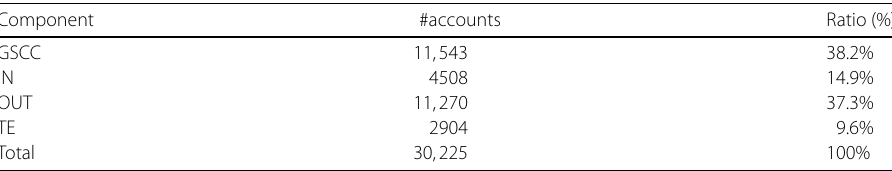
Table 4 Bowtie or “walnut” structure: size of each component